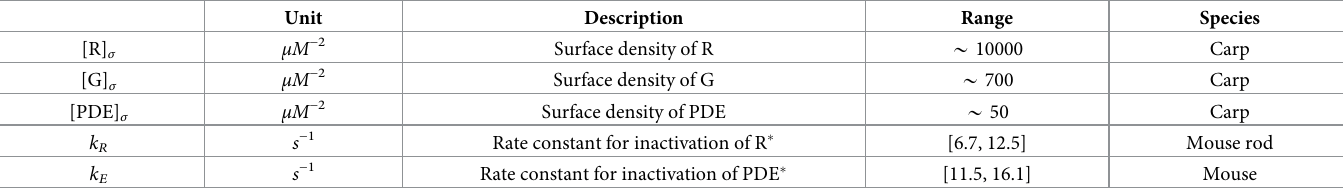
Table 2. G-protein and effector-related parameters.